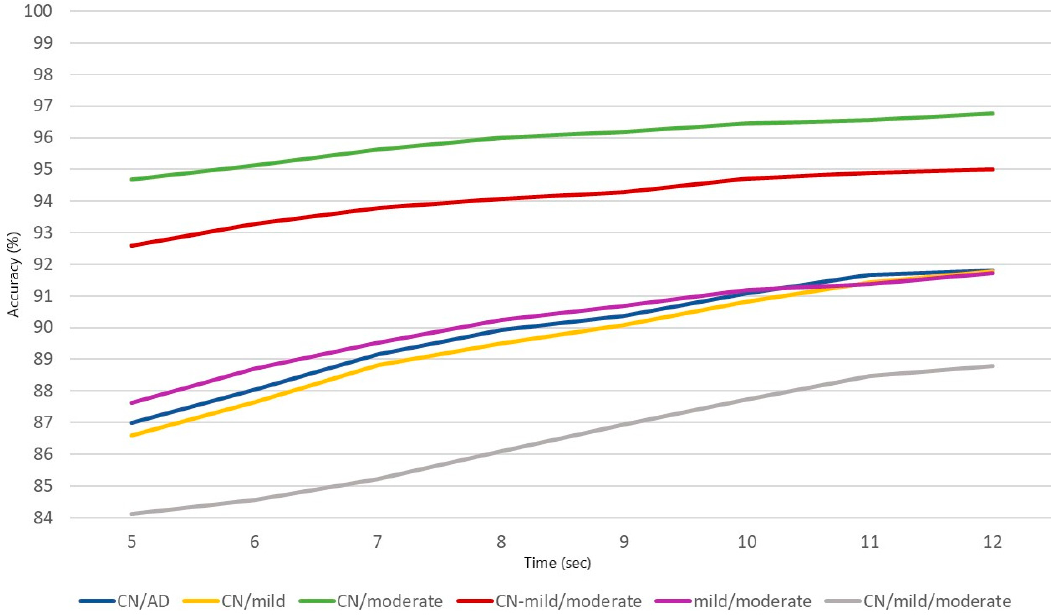
Figure 2. The results in terms of the classification accuracy for the six classification problems over 8 window lengths. (blue: CN/AD, yellow: CN/mild, green: CN/moderate, red: CN-mild/moderate, purple: mild/moderate, grey: CN/mild/moderate).